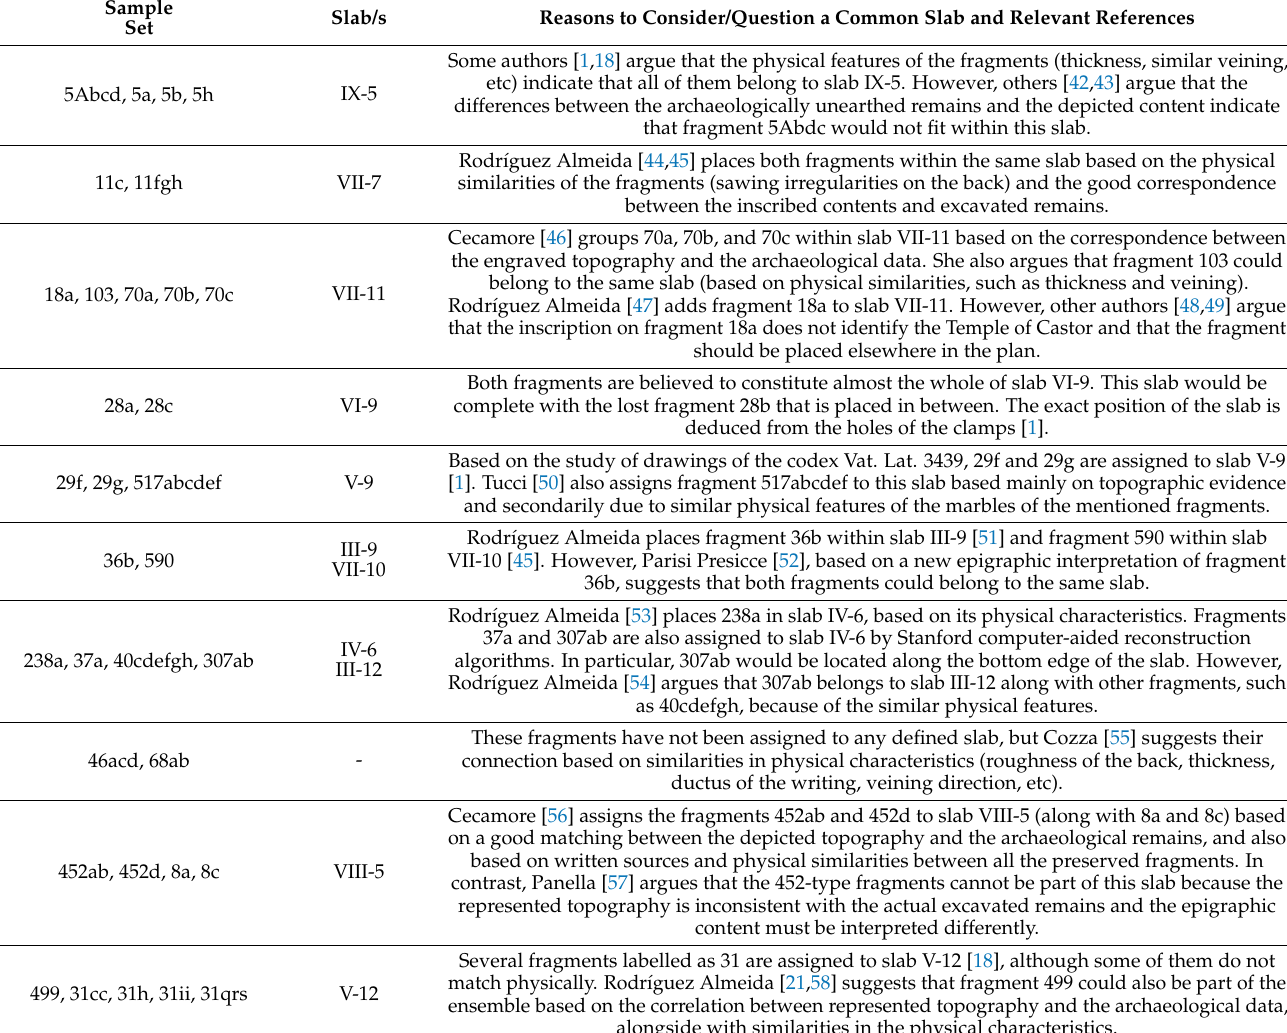
Table 1. Sample sets from group 2 that some authors have argued to be part of a single slab. Sample